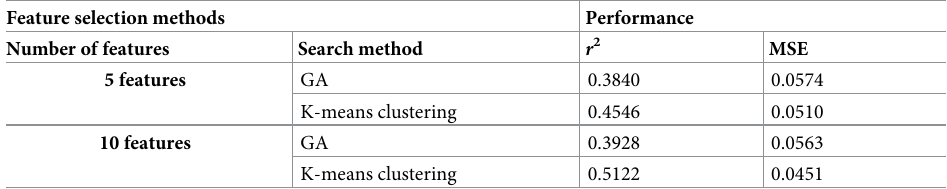
Table 12. Average performances for NNR models built by Wrapper Approach.